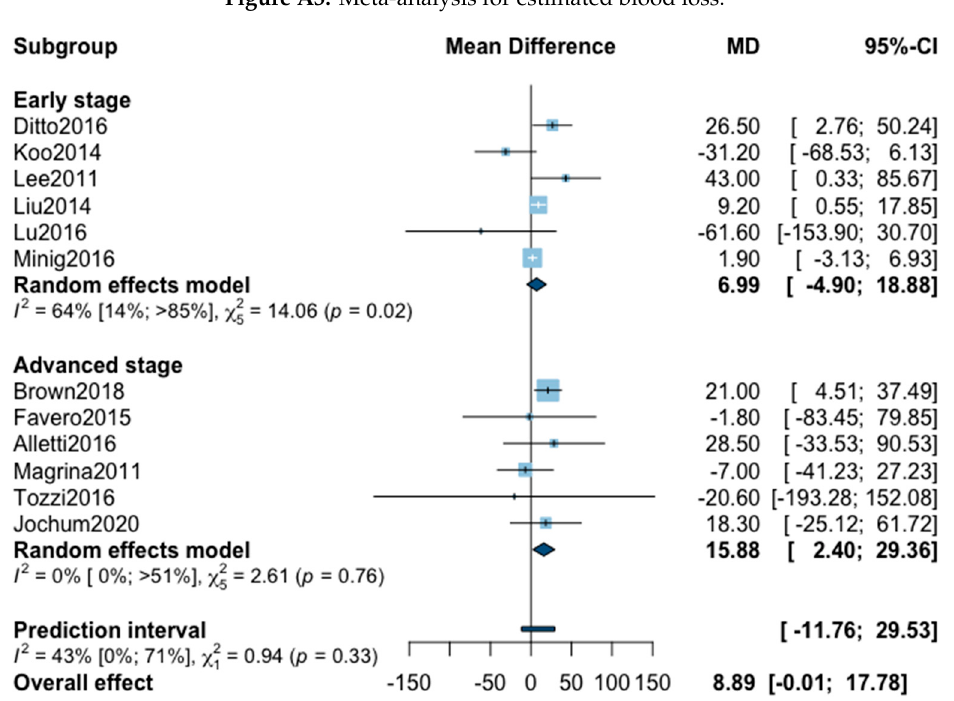
Figure A4. Meta-analysis for operative Figure A4. Meta ‐ analysis for operative time . Figure A4. Meta ‐ analysis for operative time .